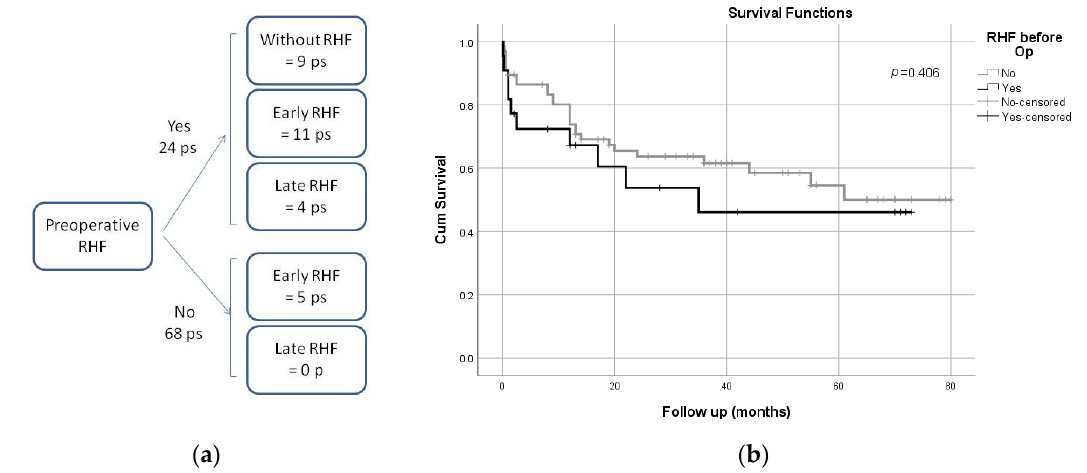
Figure 1. ( a ) Distribution of patients by RHF; preoperative, early, and late form; ( b ) survival analysis against pre-implantation RHF.